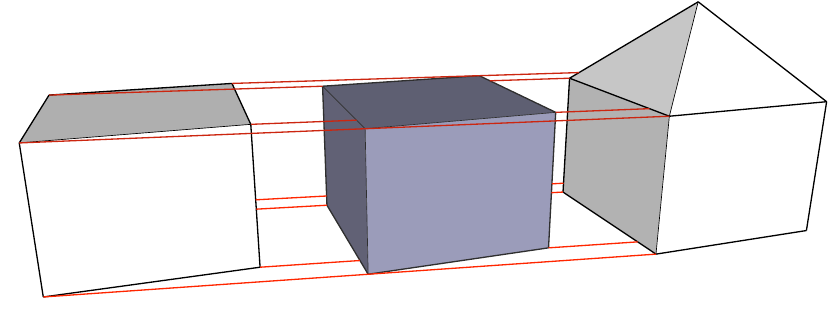
Figure 2. Two LODs of a house simply linked and the intermediate LOD